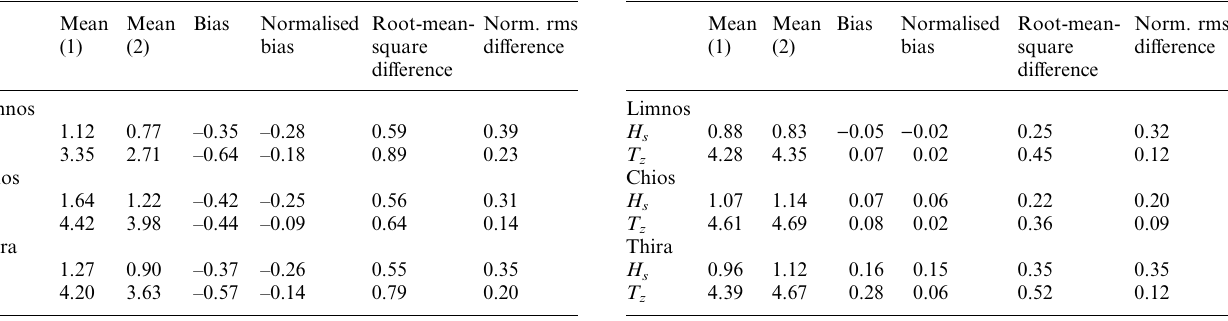
Table 9. Statistics for the storm December 1991, -128 points. Comparison of results from WAM-cy4 model using UKMO GLO